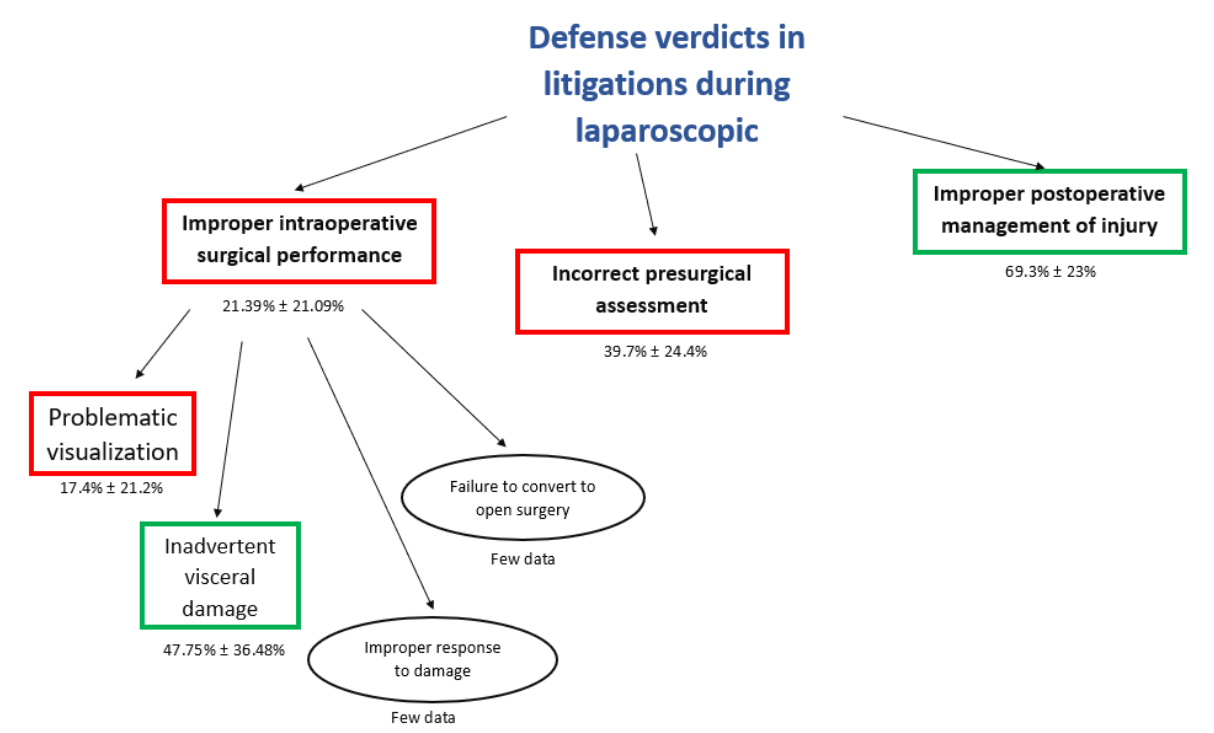
Figure 8. Flowchart of defense verdicts in litigations concerning laparoscopic cholecystectomy. The “problematic visualization” is the most frequent allegation of negligence with the lower rate of defense verdicts (17.4 ± 21.2) (Figure 9); however, the inadvertent visceral damage during cholecystectomy was associated with the higher rate of defense verdicts (47.75 ± 36.48) (Figure 10). Few data about verdicts were reported about the “failure to convert to open surgery” and “improper response to damage”.